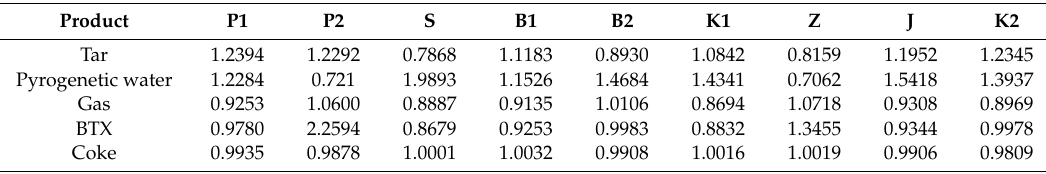
Table 4. Values of the standardized Z variable.